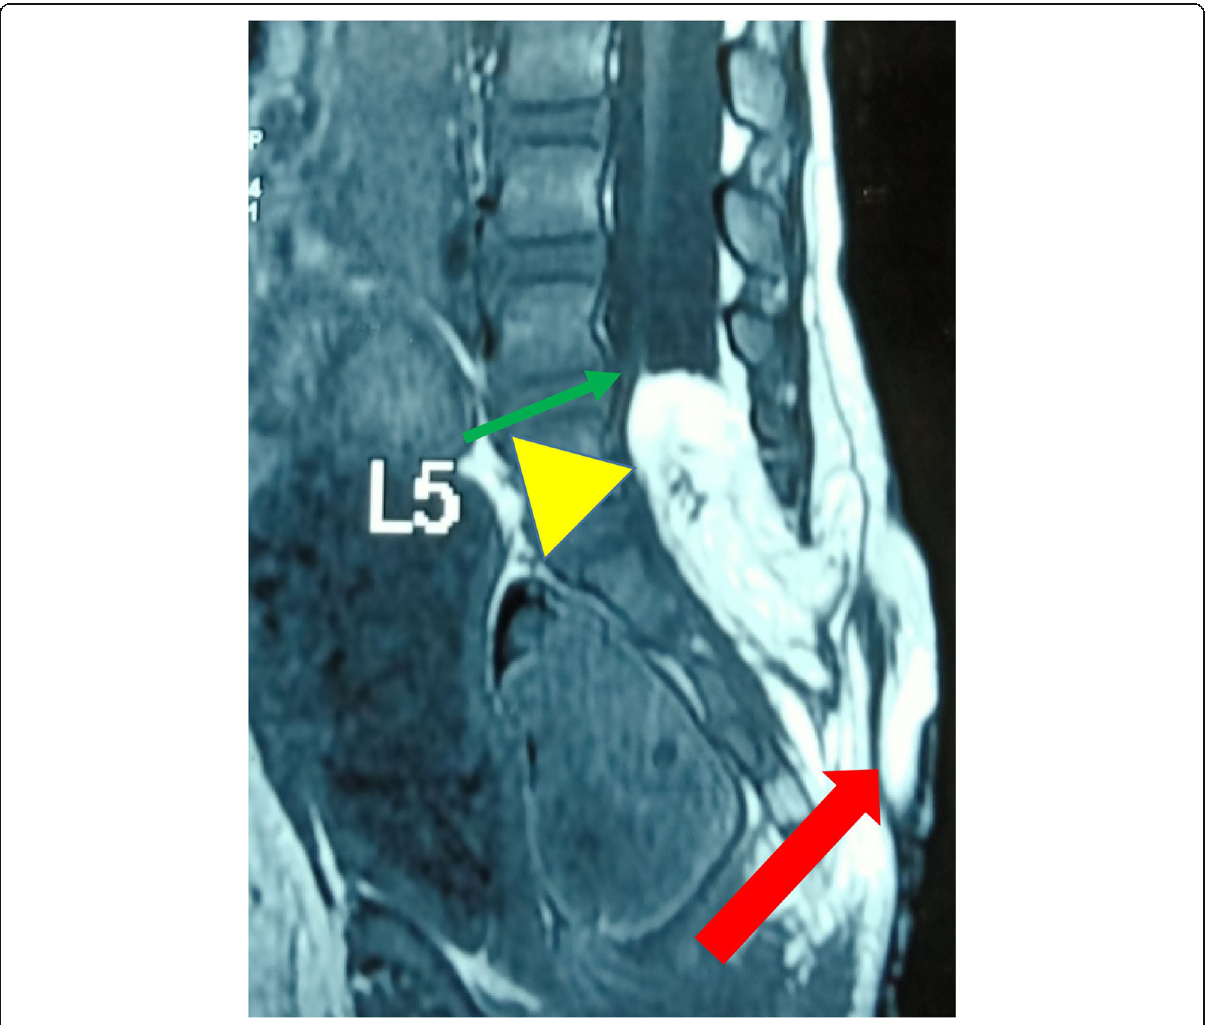
Fig. 3 Lipomyelocele with low-lying tethered cord at L4 (green arrow), extradural fat (yellow arrowhead), and pseudotail (red